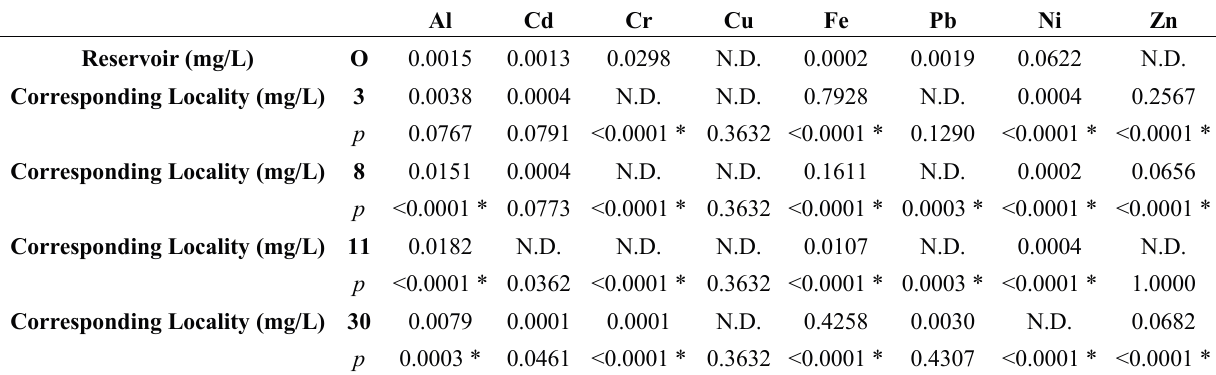
Table A12. Statistical variation between Reservoir O and its feeding Localities 3, 8, 11, 30.